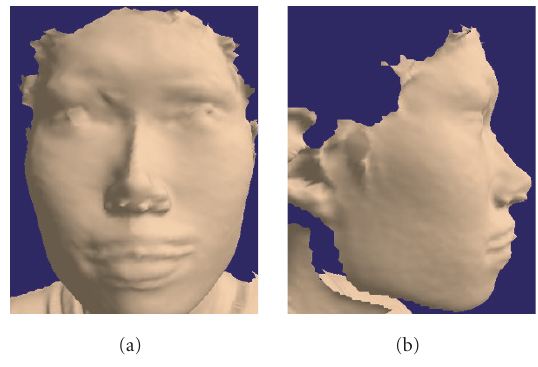
Figure 1: A face model from Minolta Vivid 700 laser